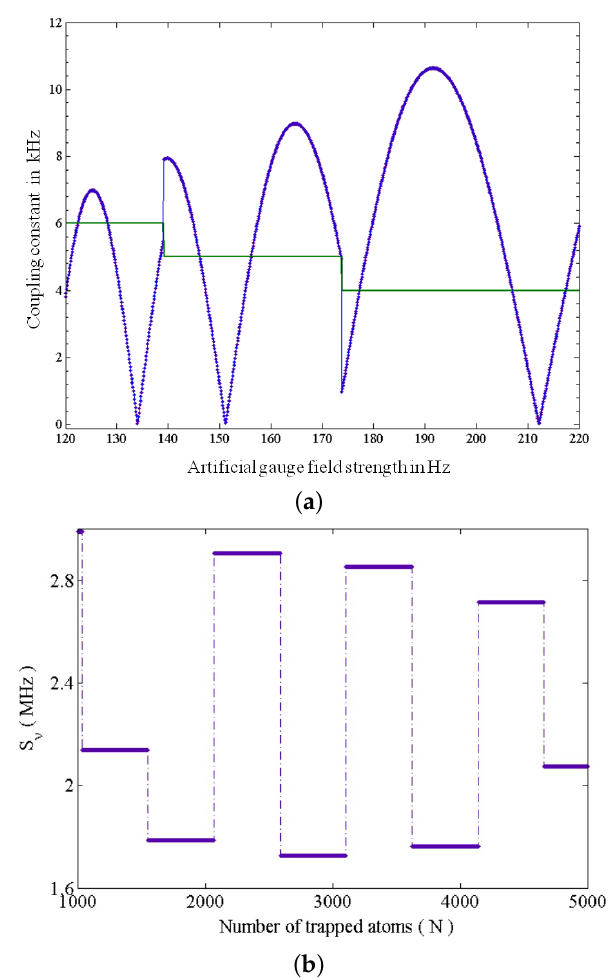
Figure 4. ( a ) Variation of coupling constant (for p = 1) with synthetic field strength. The green colored steps in the background correspond to the corresponding first empty LL, ν = 6,5,4; ( b ) variation of S ν with number of trapped atoms. Figures taken from [33]. (Reprinted figures with permission from Padhi, B.; Ghosh, S. Phys. Rev. Lett. 2013, 111, 043603. Copyright (2013) by the American Physical Society. Source: